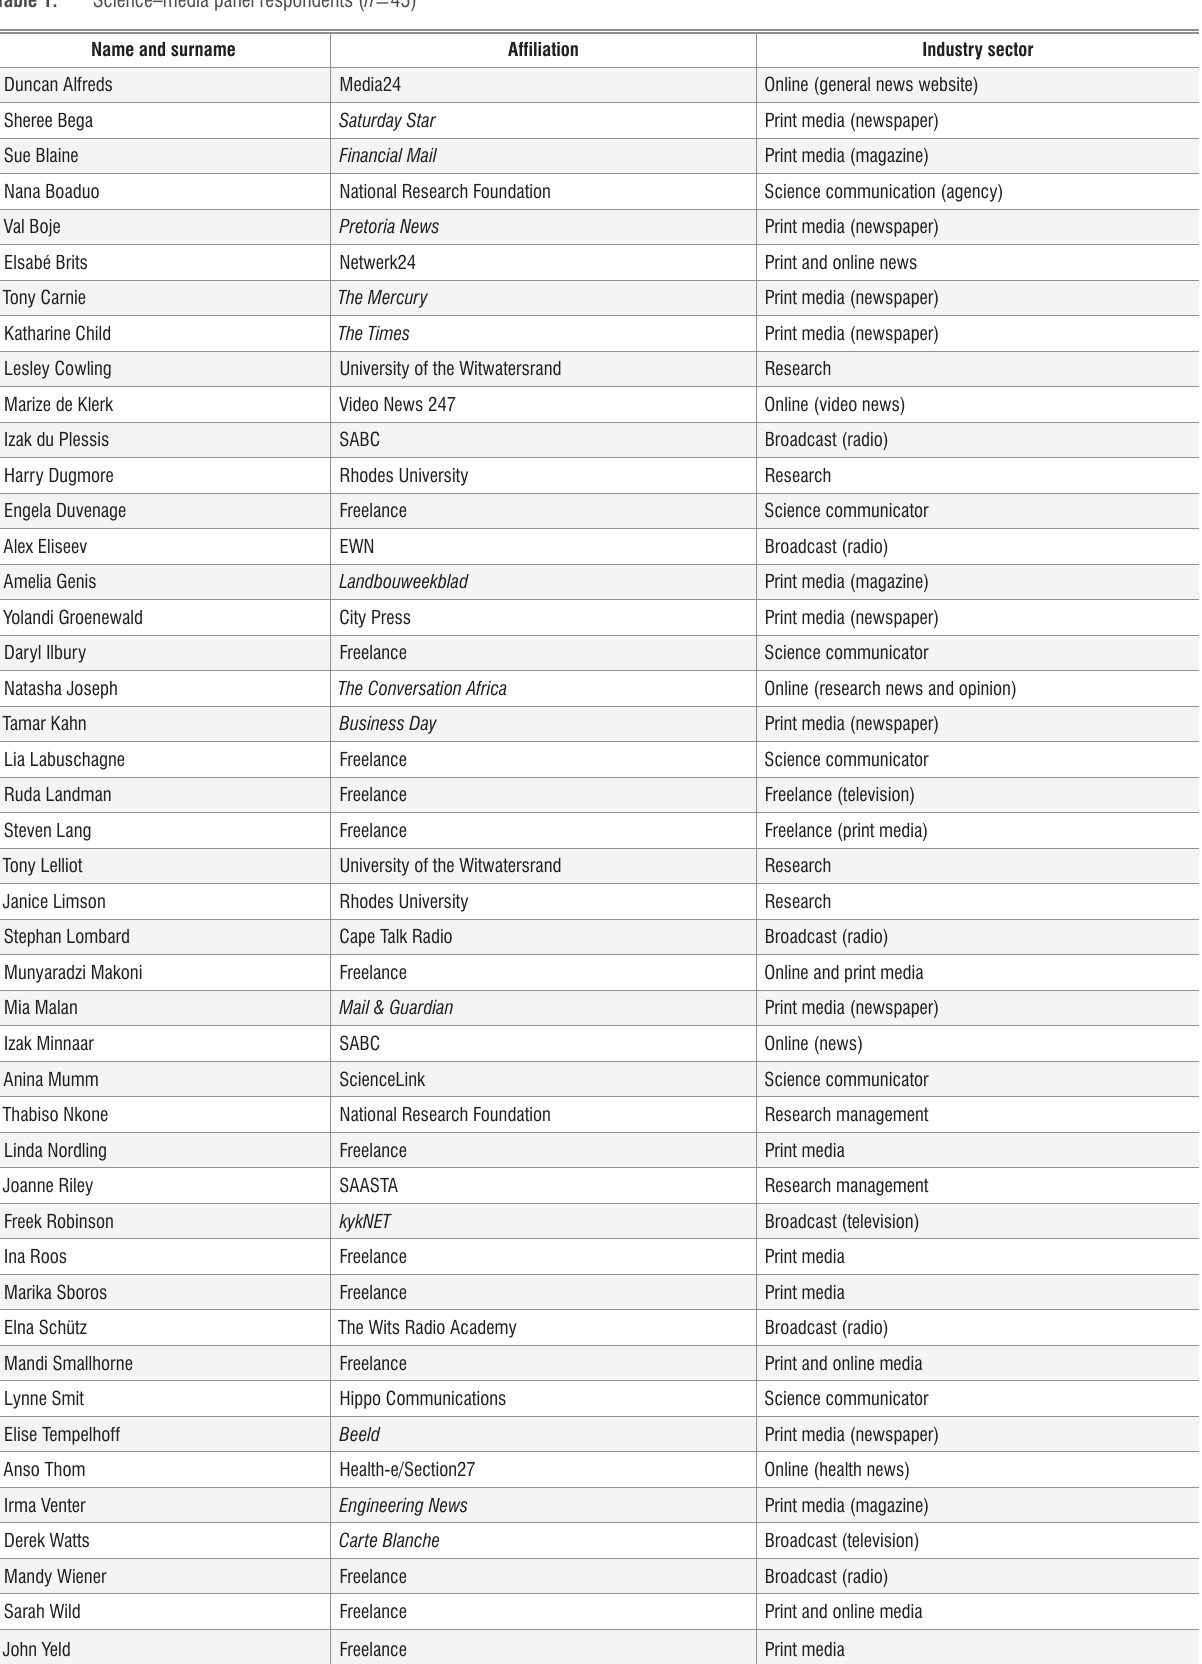
Table 1: Science–media panel respondents ( n